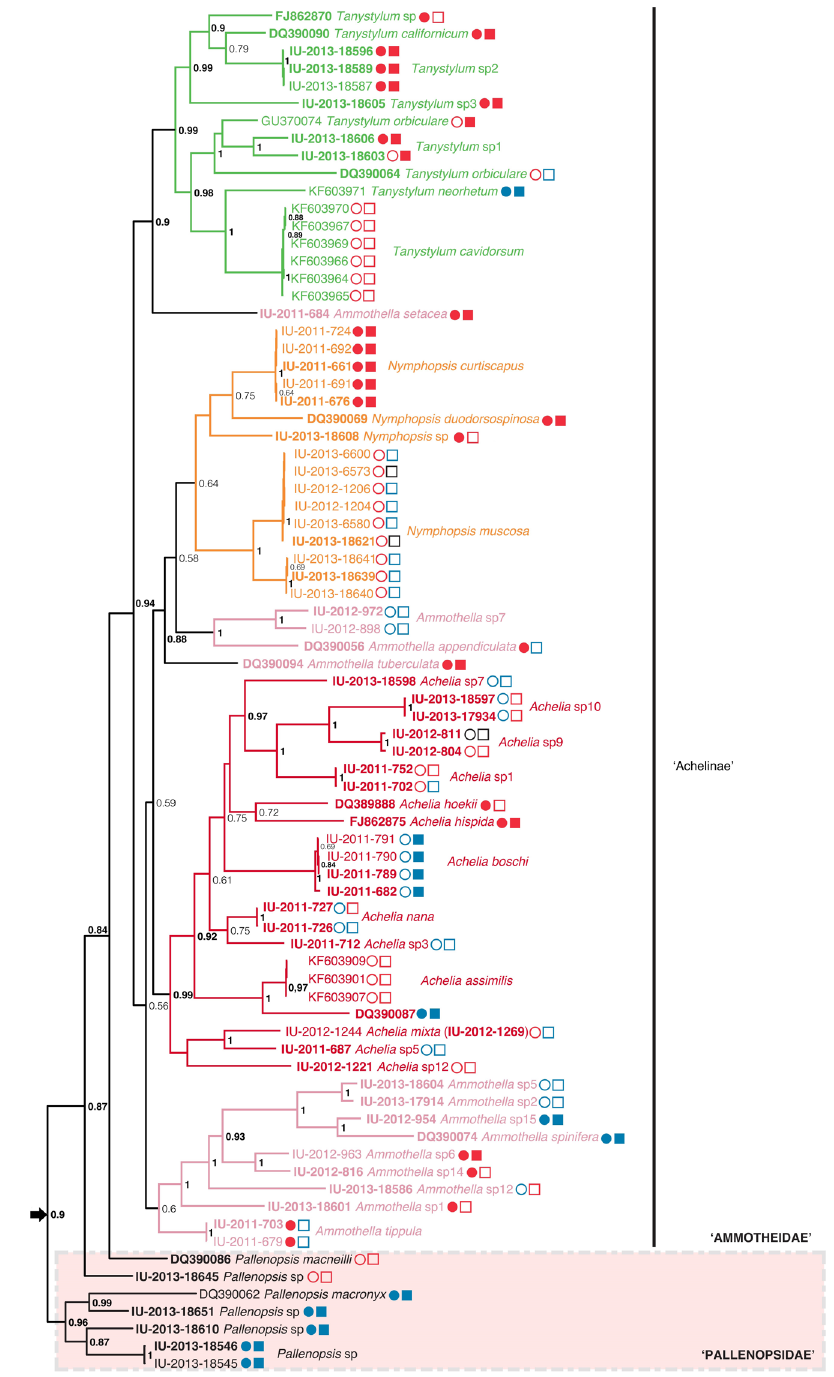
Fig. 3. Part 2, see Part 1 for